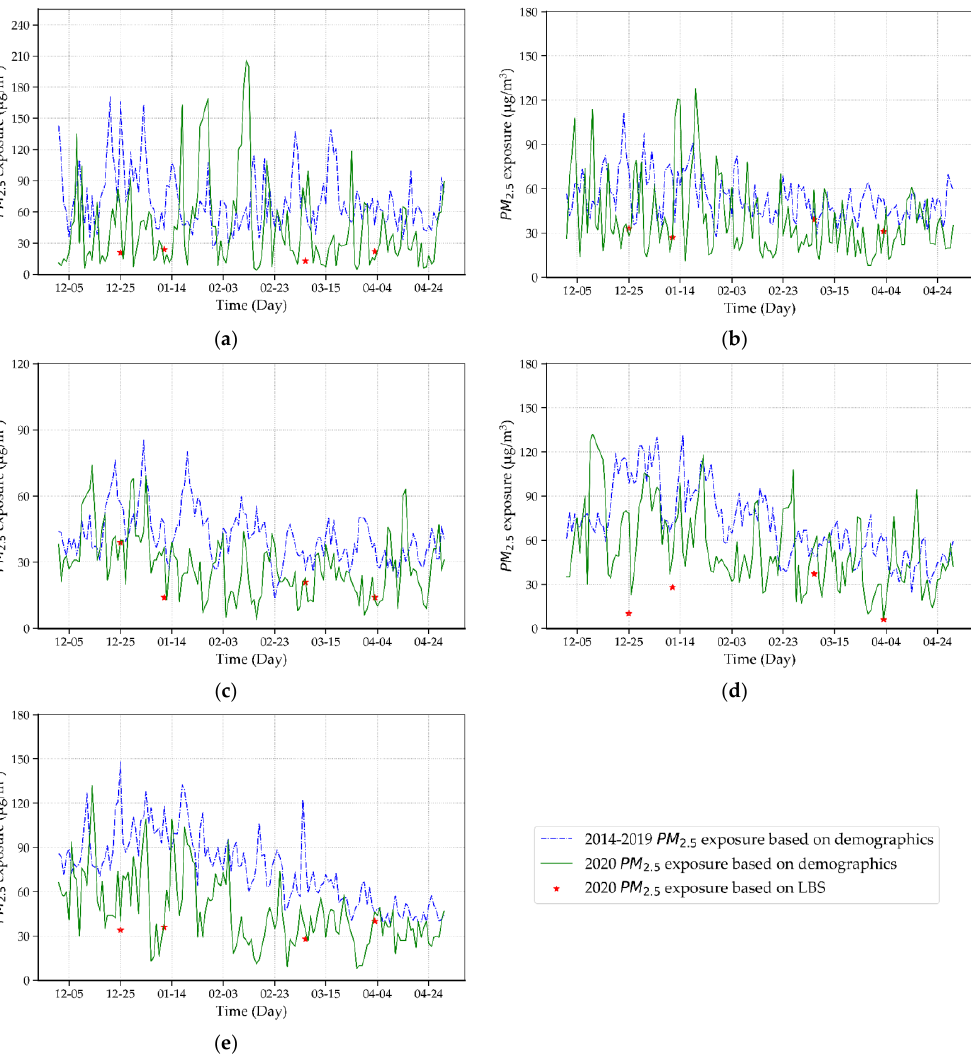
Figure 6. PM 2.5 exposure in typical population-intensive cities based on demographic and LBS data. ( a ) Beijing, ( b ) Shanghai, ( c ) Guangzhou, ( d ) Chengdu, and ( e )